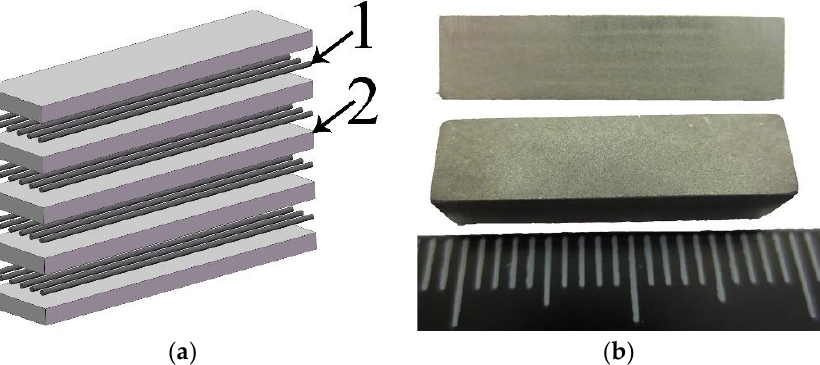
Figure 1. Reinforcement scheme: ( a ) 1—fiber, 2—powder compact; ( b ) specimen after reinforcement. Table 1. Types of specimens.